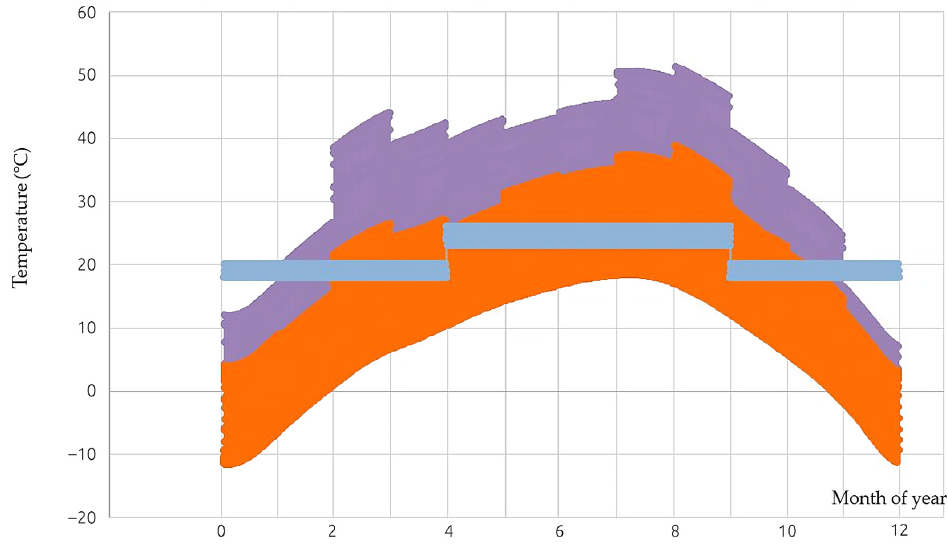
Figure 7. Example of year-round calculated temperature course in one-hour increments for outlet air temperatures from ventilated gap t vzmvyst ( orange ), temperature of outer face of T epob cladding ( purple ) and corrected internal air temperature in t ikorig building ( blue ) for entire monitored year for selected southeast façade.